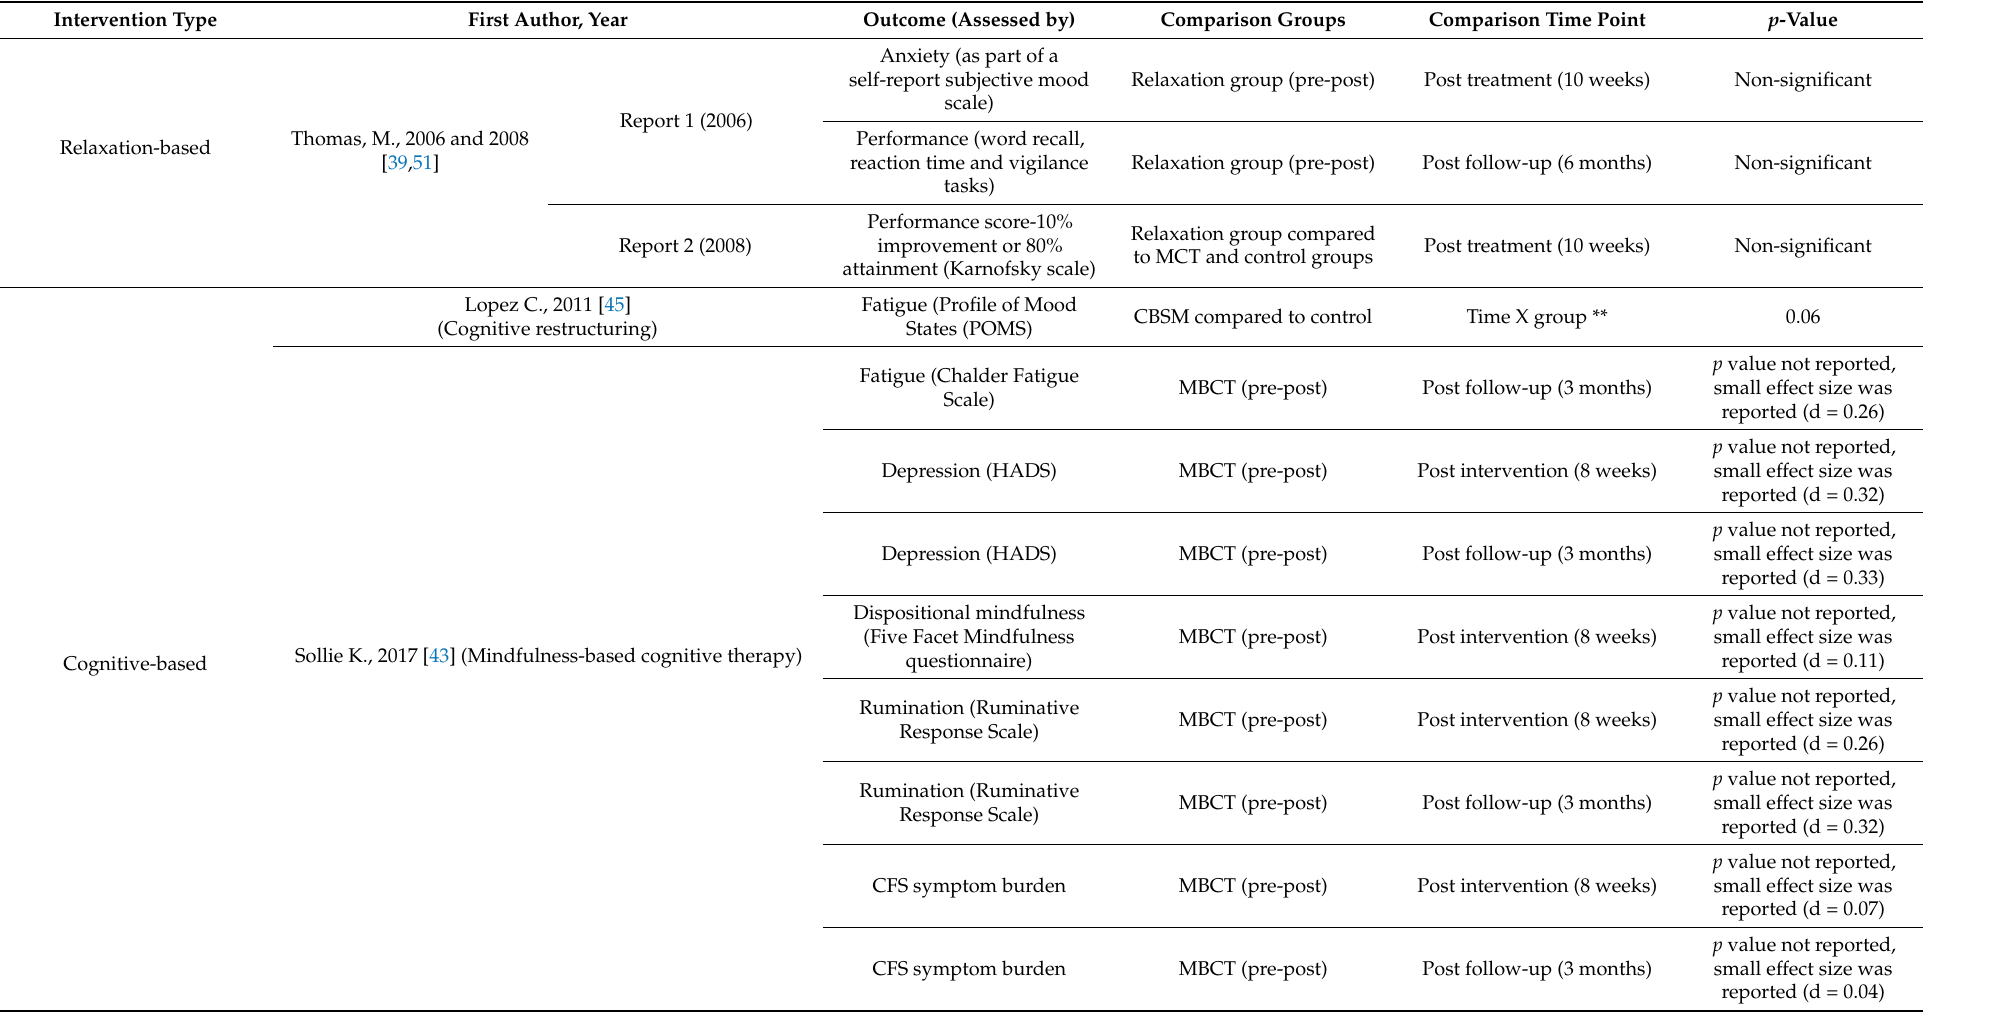
Table A3. Statistically insignificant outcomes in the included studies using CDC, Canadian and international consensus criteria for diagnosing